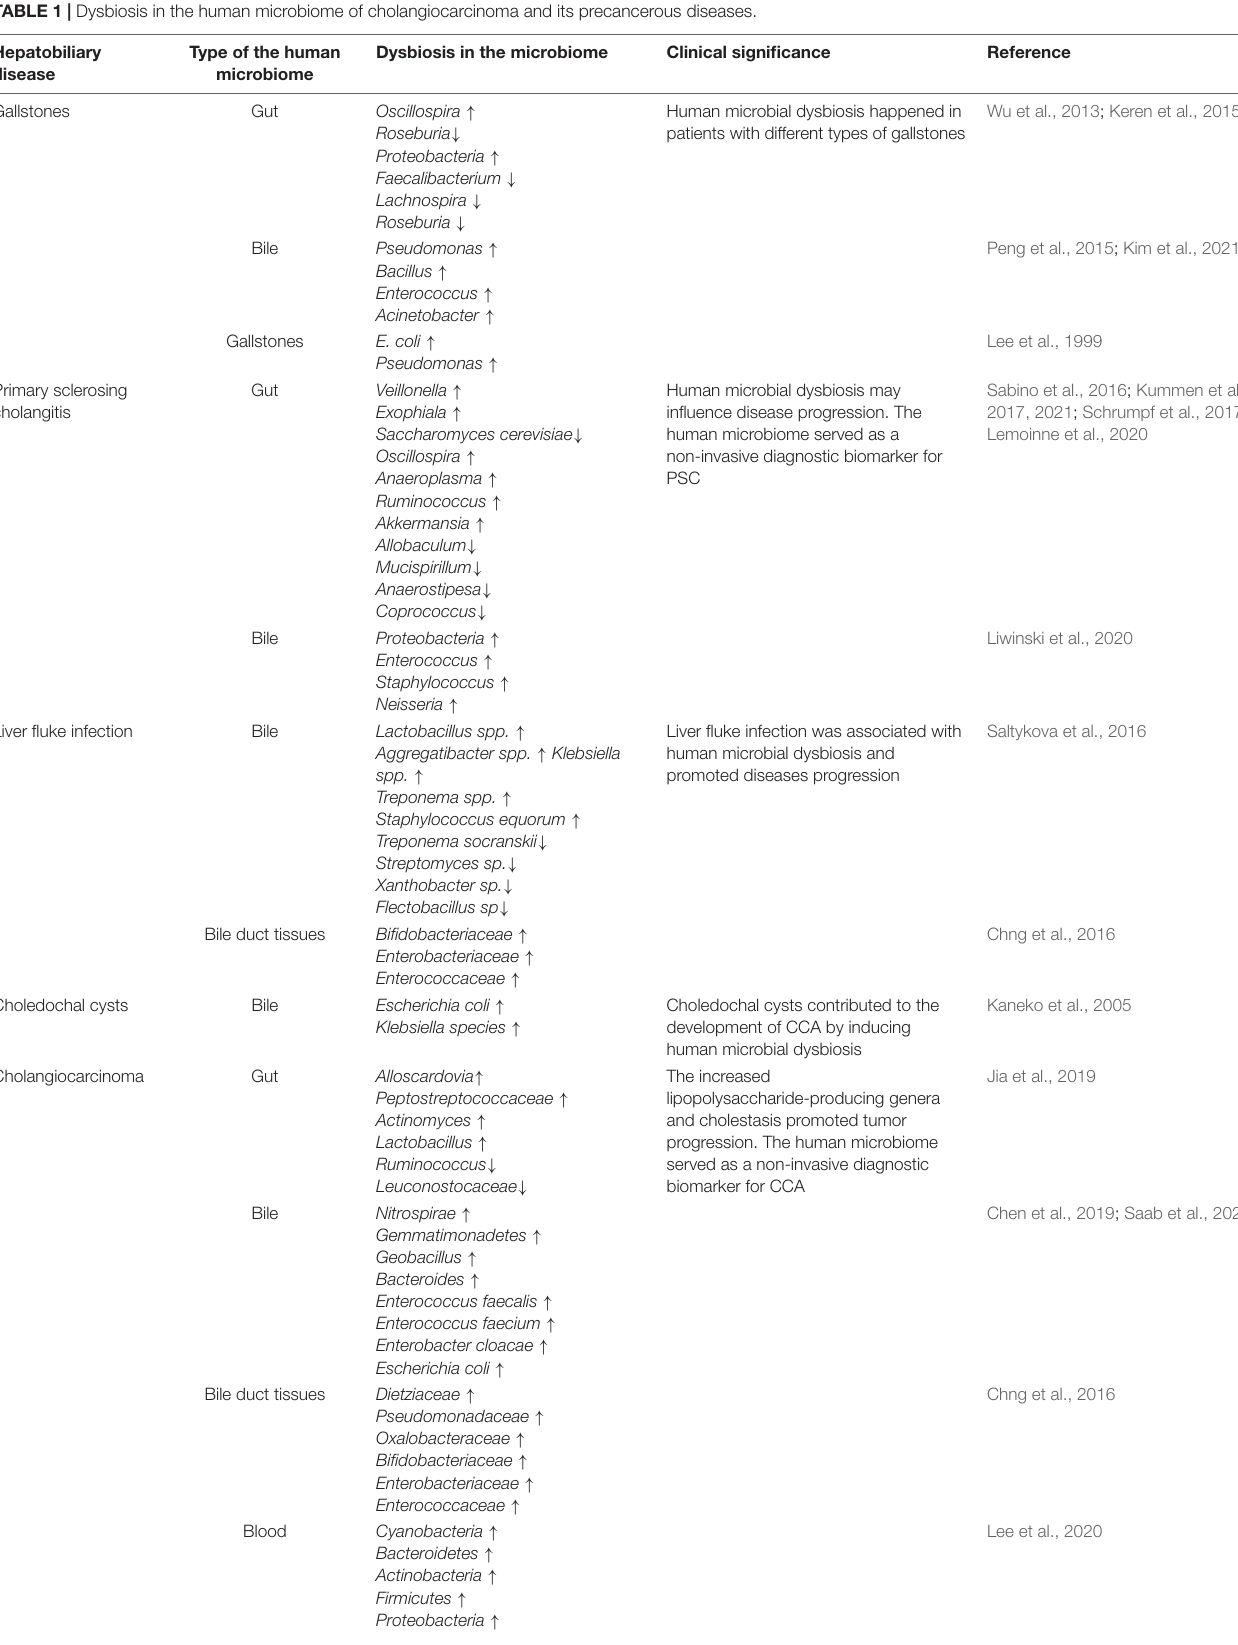
TABLE 1 | Dysbiosis in the human microbiome of cholangiocarcinoma and its precancerous